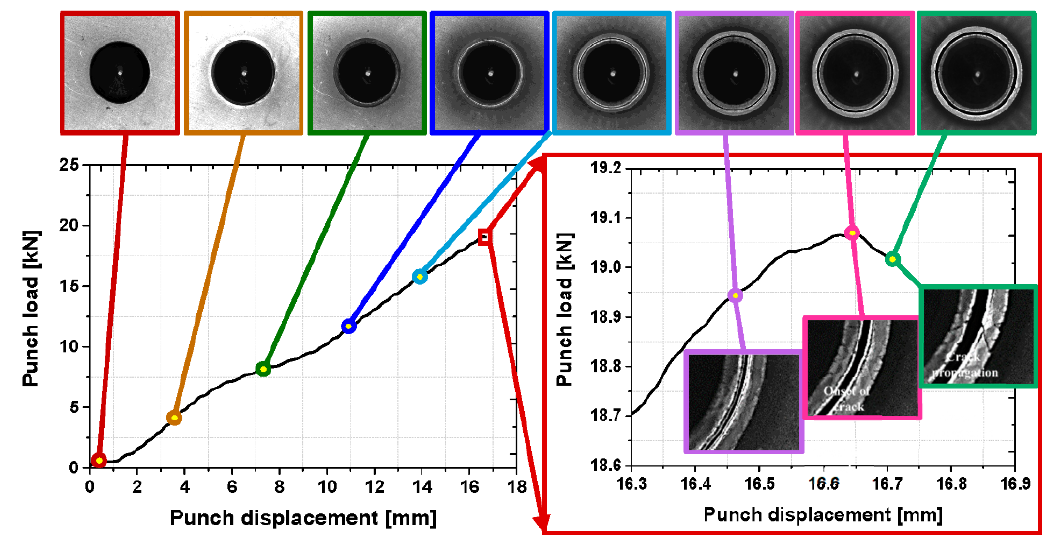
Figure 8. Matched results between test images and punch load data in integrated machine vision system.